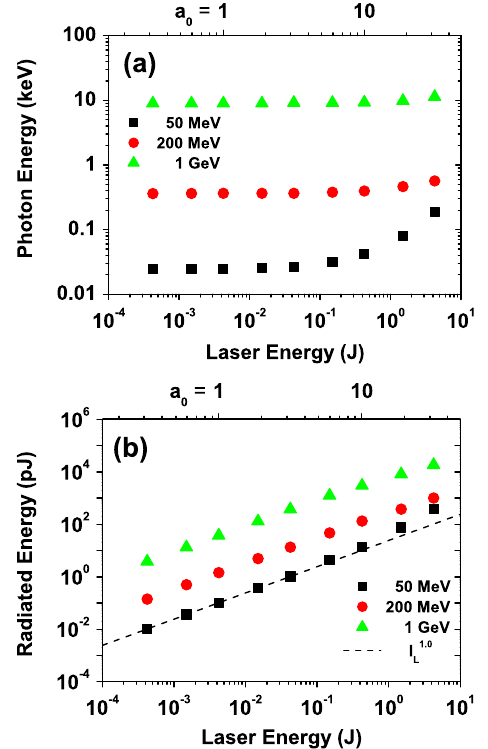
FIG. 8. Dependence of (a) averaged photon energy and (b) total radiation energy on the laser energy for various electron energies. The upper horizontal axis indicates the normalized vector potential, a 0 , which corresponds to the laser energy in the lower horizontal axis. The dashed line of (b) is a fitting line proportional to the first power of laser